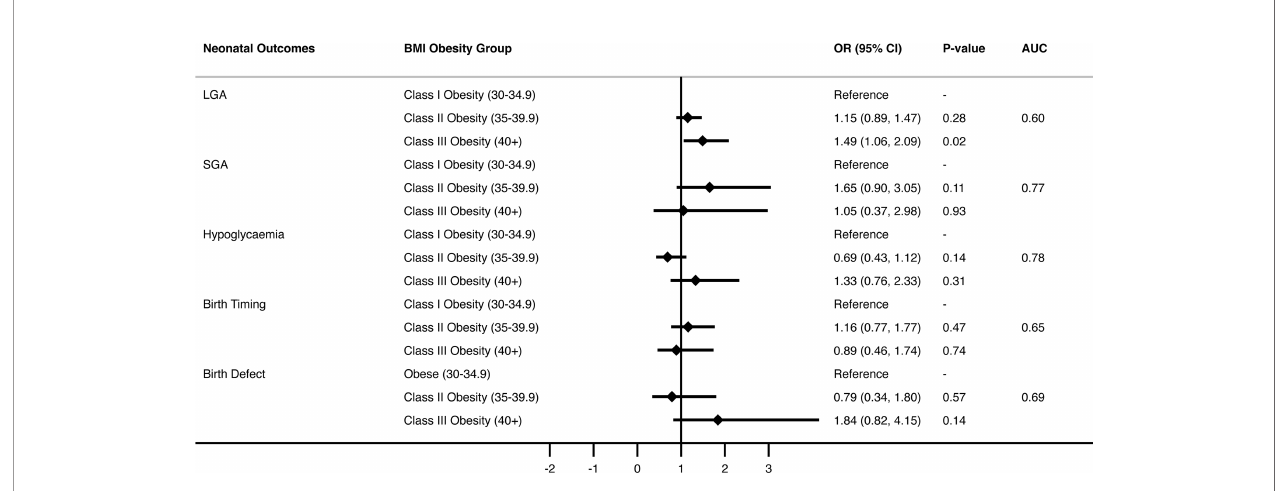
FIGURE 2 | Multivariate logistic regression model of fi ve neonatal outcomes by BMI group.